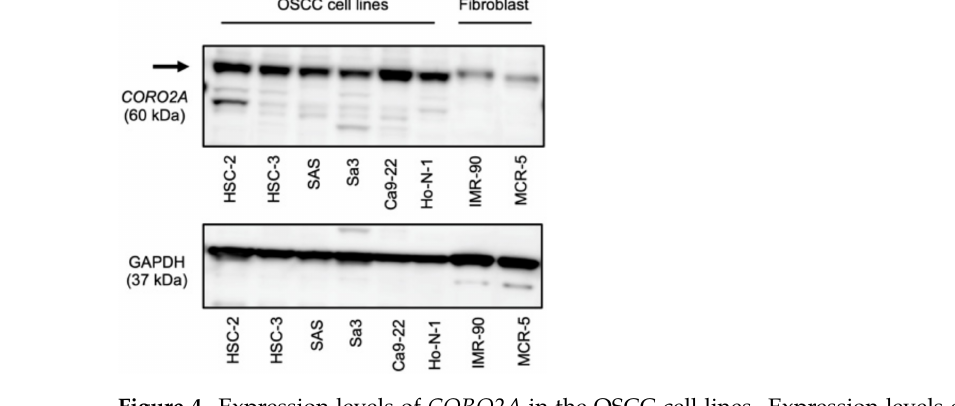
Figure 4. Expression levels of CORO2A in the OSCC cell lines. Expression levels of CORO2A in OSCC cell lines and normal fibroblast cell lines were evaluated with Western blotting. GAPDH was used as the internal control.